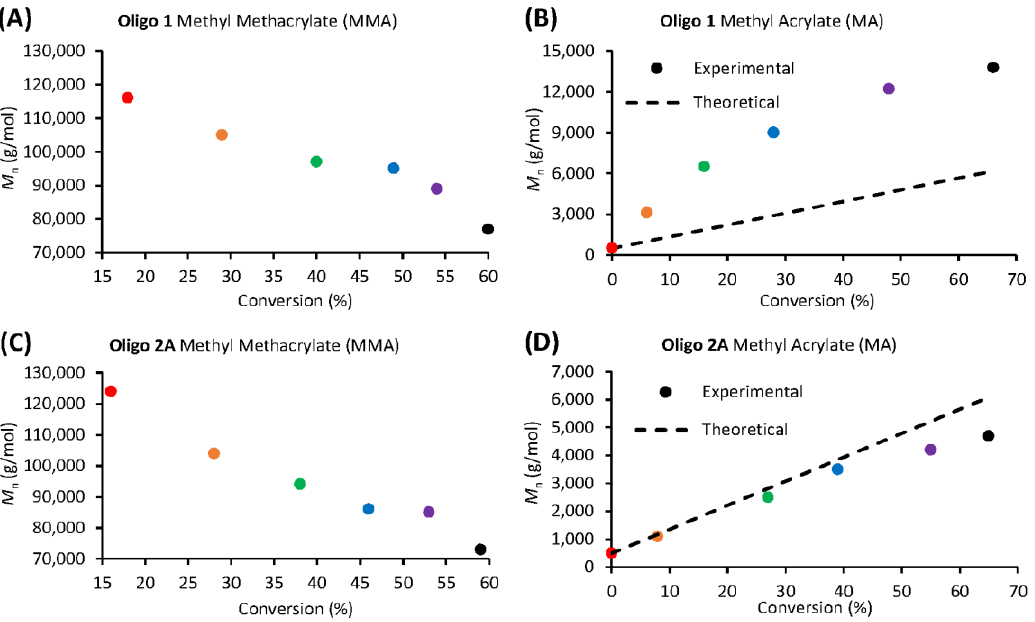
Figure 6. Number average molecular weight vs conversion plots for RAFT oligomer solution polymerizations in DMF ( A ) Oligo 1 + MMA, ( B ) Oligo 1 + MA, ( C ) Oligo 2A + MMA and ( D ) Oligo 2A + MA.